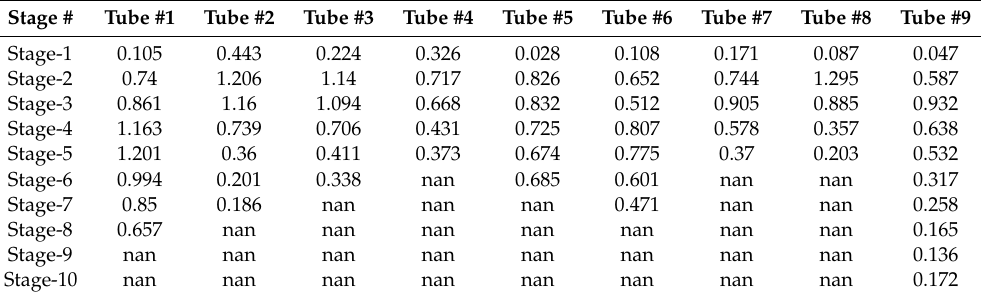
Table 5. Average RMS of AE in each region by each tube (nan means no values).